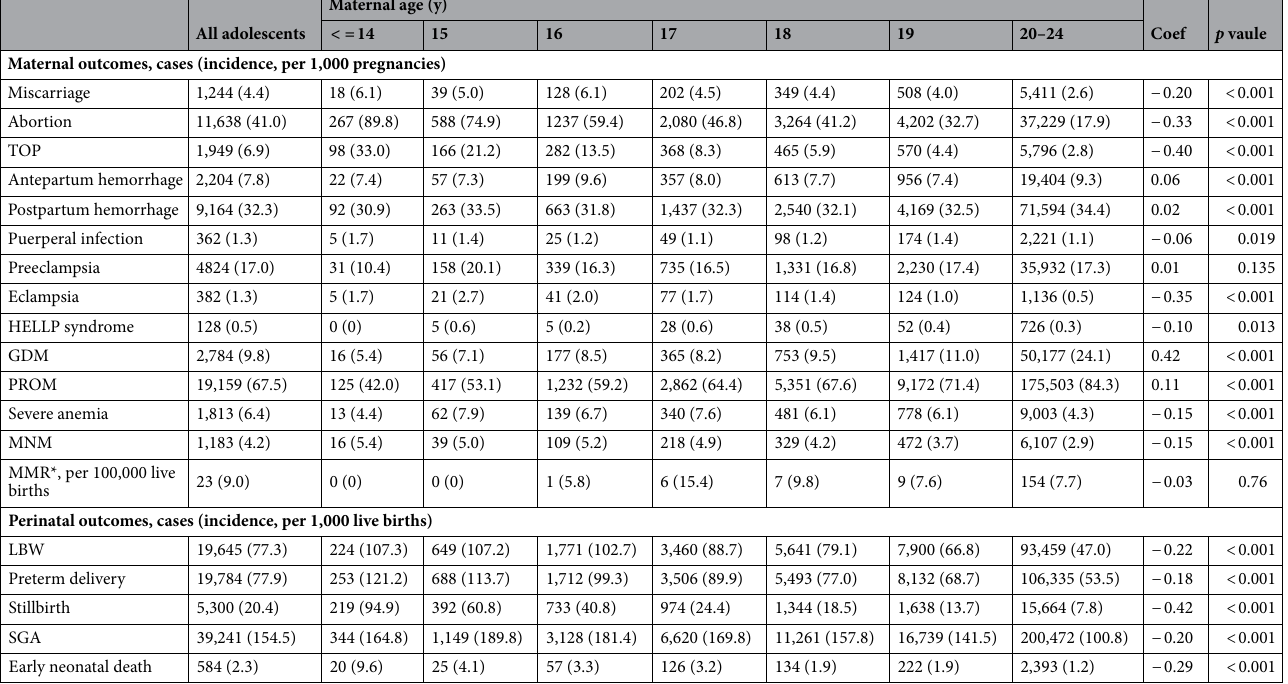
Table 2. Incidence of adverse maternal and perinatal outcome according to maternal age in China, 2012– 2019 . TOP terminate of pregnancy; TOP refers to induced labor at more than 28 weeks of gestation due to fetal or maternal causes. GDM gestational diabetes mellitus, PROM premature rupture of membranes, MMR maternal mortality ration, MNM maternal near miss, LBW low birth weight, SGA small-for-gestation-age. *MMR refers to the maternal mortality ratio during